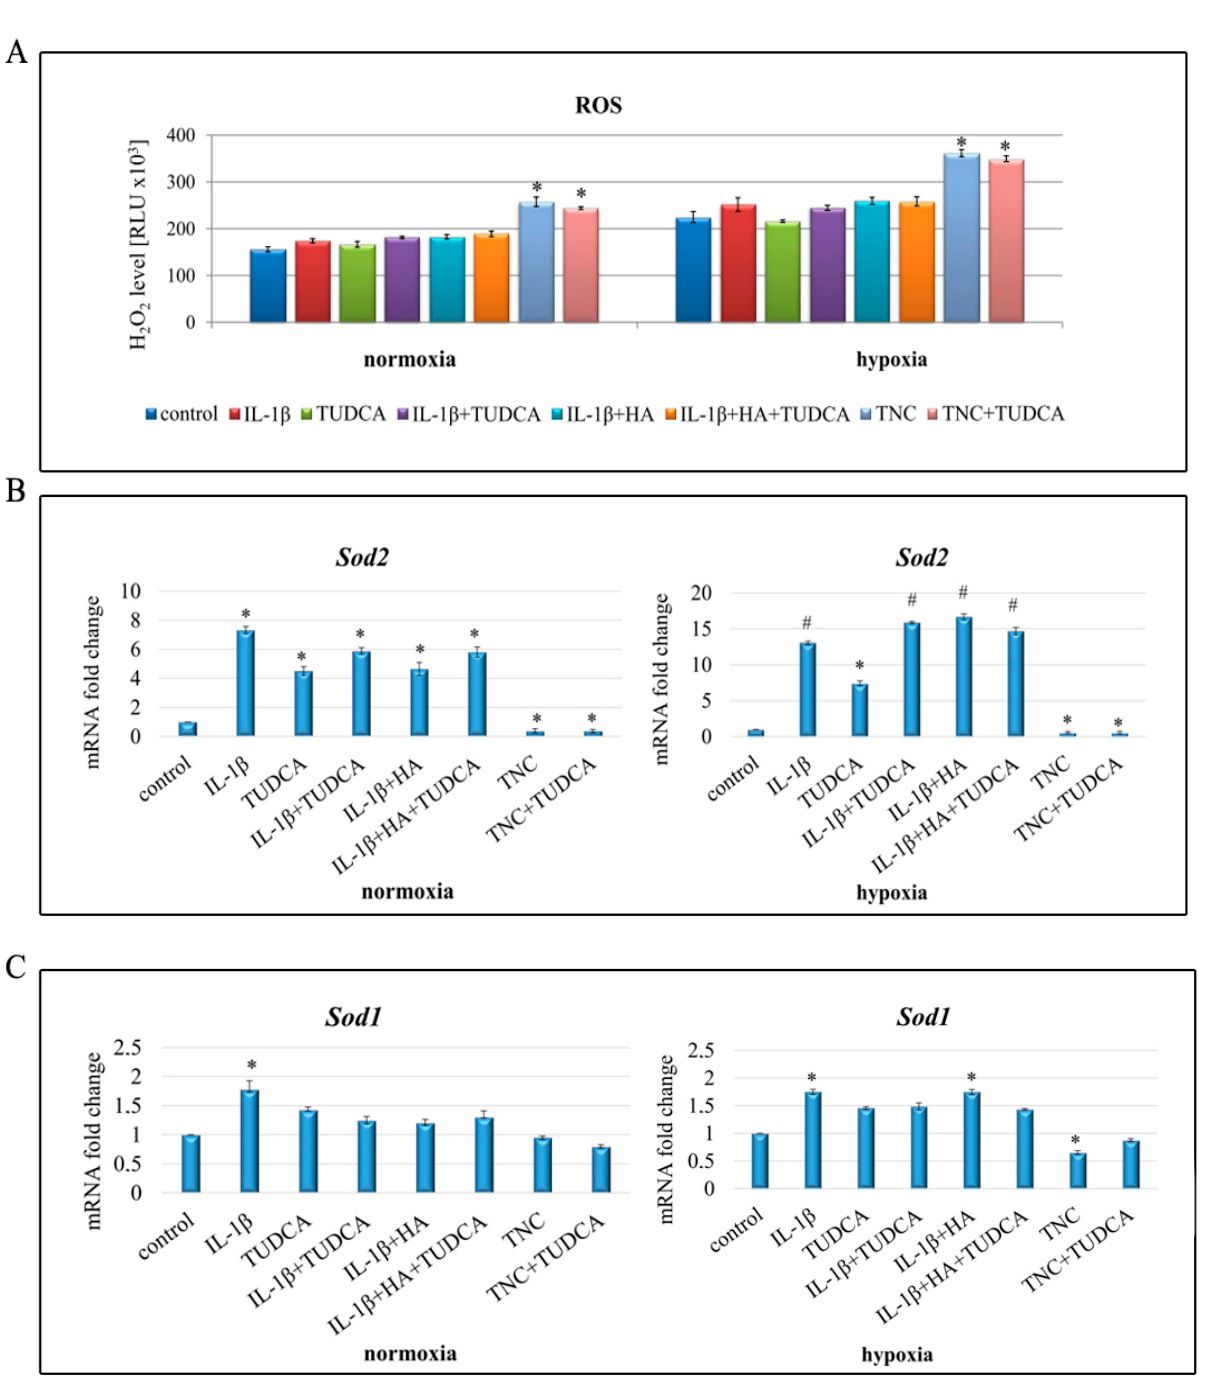
Figure 5. Influence on oxidative stress in NHAC-kn chondrocyte cells stimulated with IL-1 β , TUDCA, IL-1 β +TUDCA, IL-1 β +HA, IL-1 β +HA+TUDCA, TNC, and TNC+TUDCA for 72 h. H 2 O 2 production ( A ). Results presented as relative luminescence units and compared to untreated controls. Relative quantification of Sod2 ( B ) and Sod1 ( C ) expressions in normoxic and hypoxic conditions. Results shown as relative fold change in mRNA expression in comparison to untreated controls, where expression level was set as 1. Results of qPCR and luminescence-based analyses are presented as mean ± SD from three independent experiments run in triplicate. Significant changes are expressed relative to controls and marked with asterisks and hashes. Statistical significance was considered if * p < 0.05 or # p < 0.001.